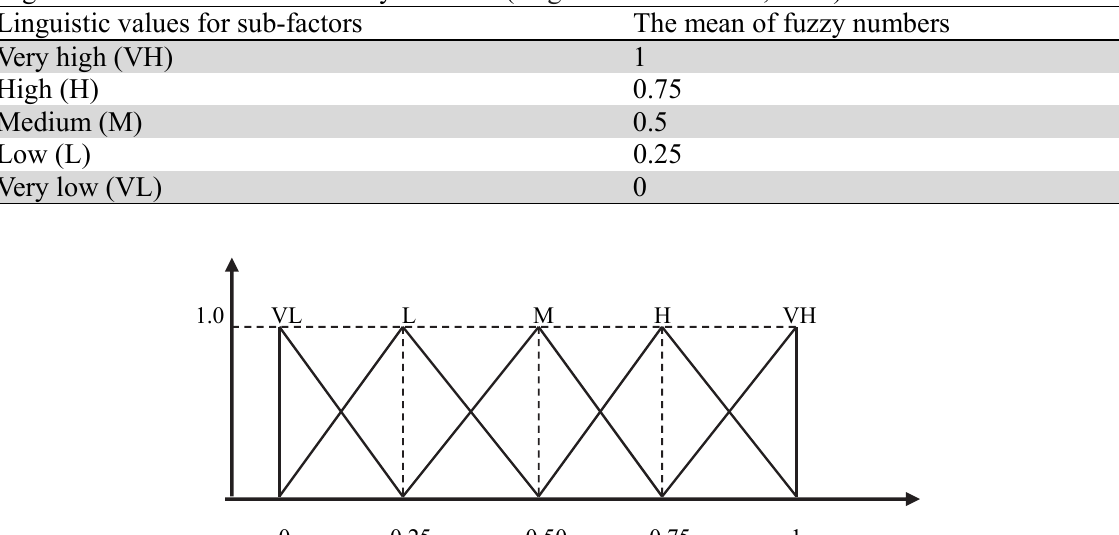
Linguistic values and mean of fuzzy numbers (Da ğ deviren & Yüksel, 2010)